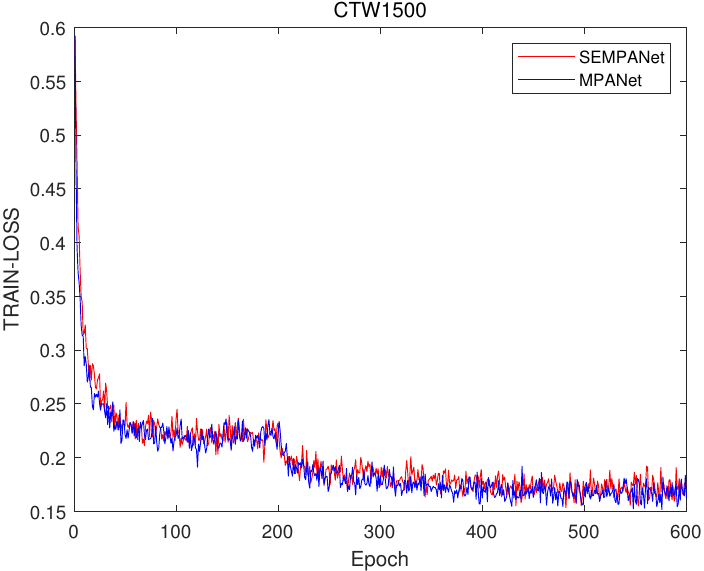
Figure 4. Ablation study of an SE block on ICDAR2015. These results are based on (ResNet 50 and SE block) and (ResNet 50 block) trained on MPANet.